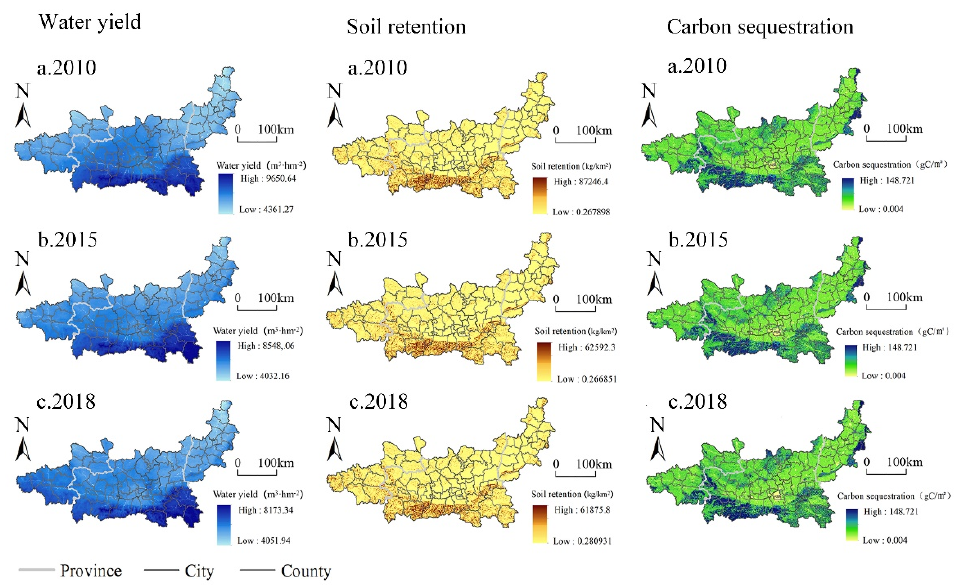
Figure 4. Spatial–temporal distribution of water conservation, soil conservation, and carbon seques- tration in Guanzhong Plain urban agglomeration from 2010 to 2018.